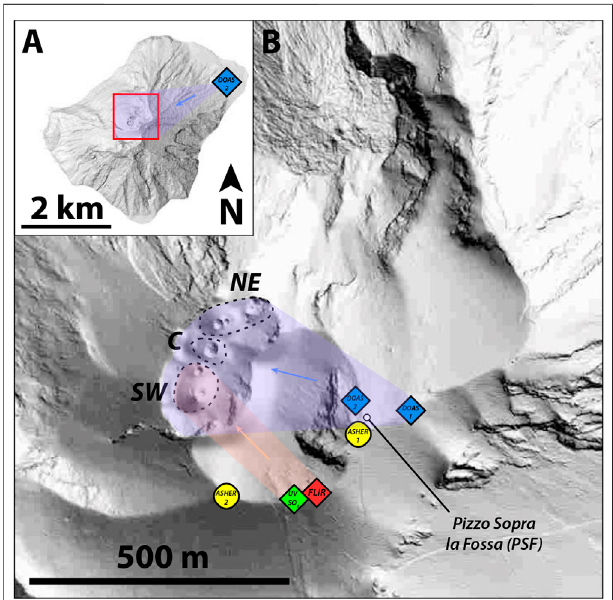
FIGURE 1 | (A) Digital Elevation Model (DEM) of Stromboli Island, with the location of the Differential Optical Absorption Spectroscopy (DOAS) instrument. (B) DEM of the summit area of Stromboli volcano with the locations of the Forward Looking Infra-Red (FLIR) camera, the Ultra- Violet(UV)SO 2 camera,theASHcollectorandsizER(ASHER)instrument (two different positions), and the DOAS instrument (two different positions). The three different active zones of Stromboli volcano are materialized: the South West (SW) crater, the Central (C) crater, and the North East (NE)